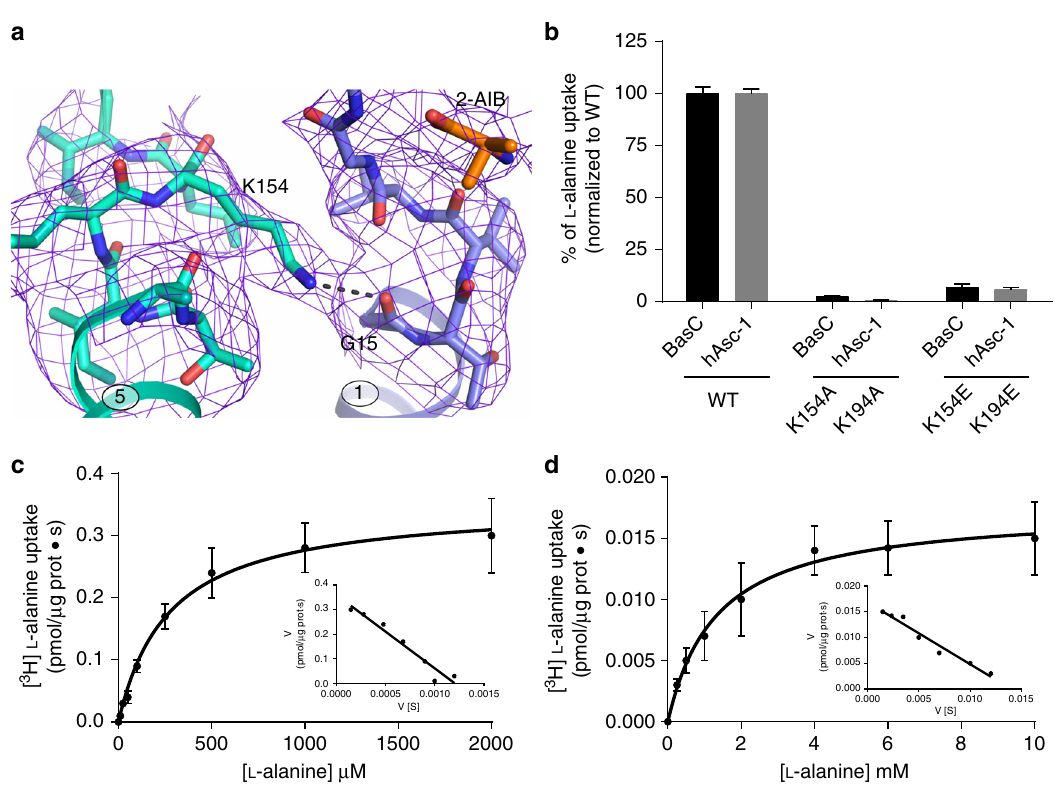
Fig. 5 Role of Lys 154 in the asymmetry of the substrate interaction. a Lys 154 forms an H bond with Gly 15 at the C-terminal end of TM 1a in the BasC holo structure. 2Fo-Fc electron density map (blue) is shown. b 10 µ M [ 3 H] L -alanine/4 mM L -alanine exchange by BasC reconstituted in proteoliposomes (PLs) (black bars) and transport of 10 µ M [ 3 H] L -alanine in HeLa cells by human Asc-1 (hAsc-1) (gray bars). Wild-type (WT) and the indicated homologous mutants of BasC and human Asc-1 (hAsc-1) were studied. In b , data (mean ± s.e.m.) normalized to WT values from 3 independent experiments are shown. Representative kinetic experiments of either extracellular ( c ) or cytoplasmic ( d ) sides of K154A BasC mutant reconstituted in PLs. In both cases, kinetics was examined in the presence of 5 µ M Nb74 to monitor only right-side-out-oriented transporters. In c , d , data (mean ± s.e.m.) correspond to quadruplicates. Eadie-Hofstee transformation of the kinetics presented in c and d is shown in the insets. Source data are provided as a Source Data fi